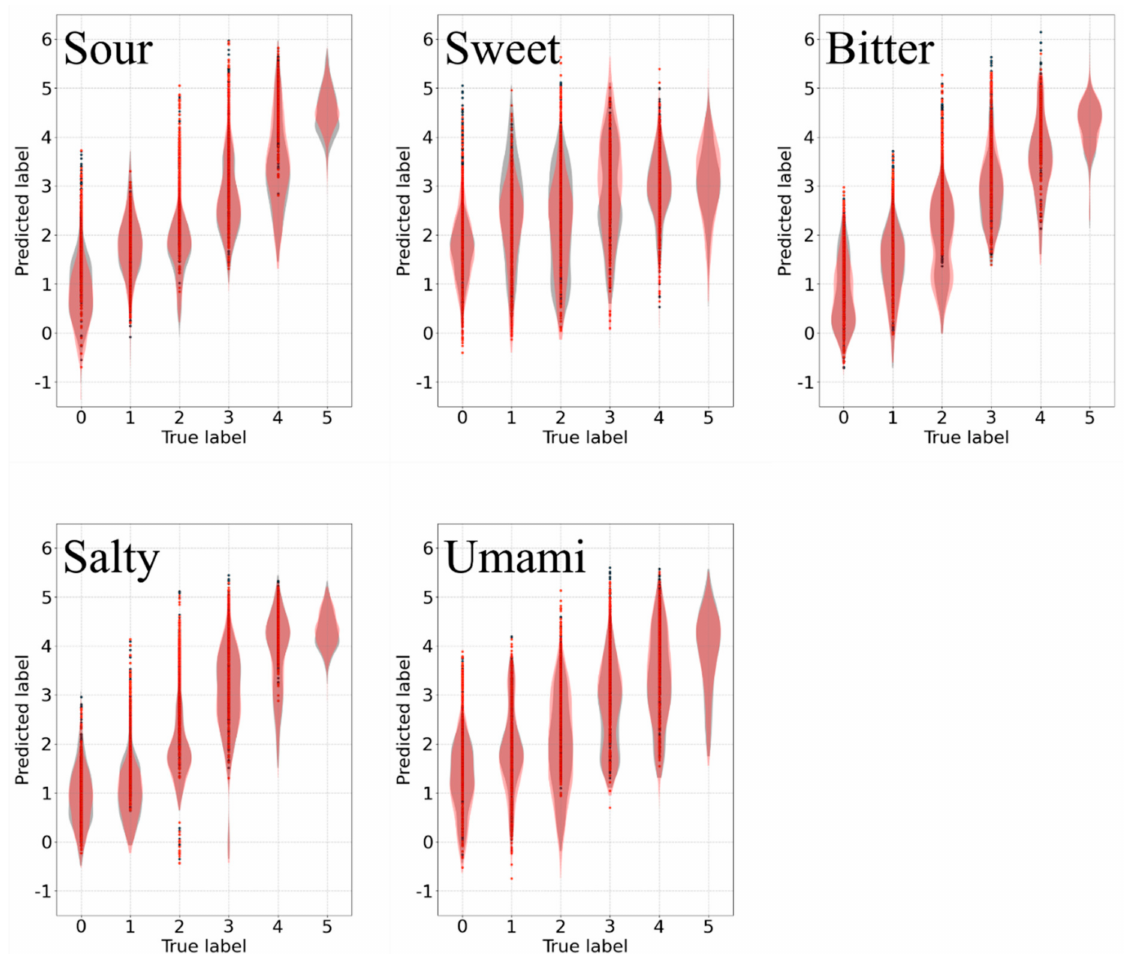
Figure 9. Regression results after feature dimensionality reduction. The regression result for each primary taste type is shown with a violin plot and the width of the shape is the density of data points. The black shape represents data points before feature dimensionality reduction and the red shape represents data points after feature dimensionality reduction. The abscissa coordinate is the true strength label, the vertical coordinate is the predicted strength